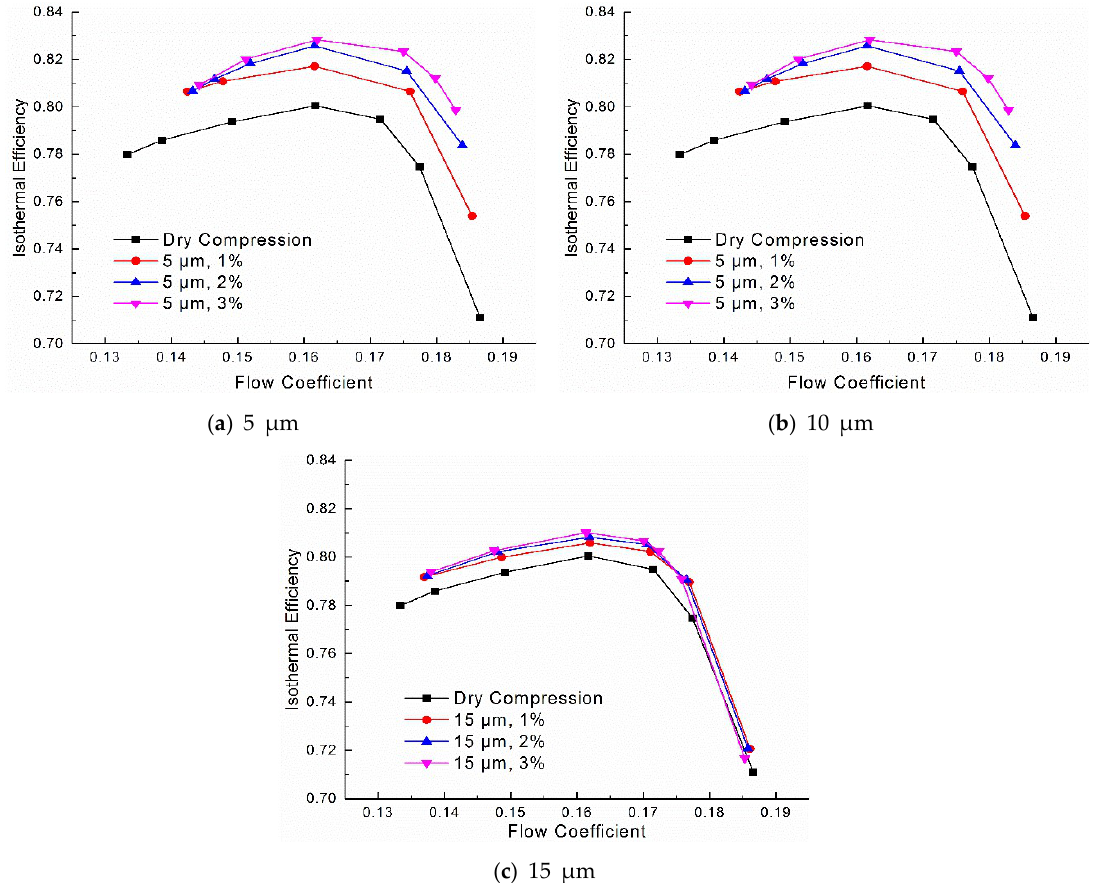
Figure 7. Comparison of the isothermal efficiency between dry and wet compression